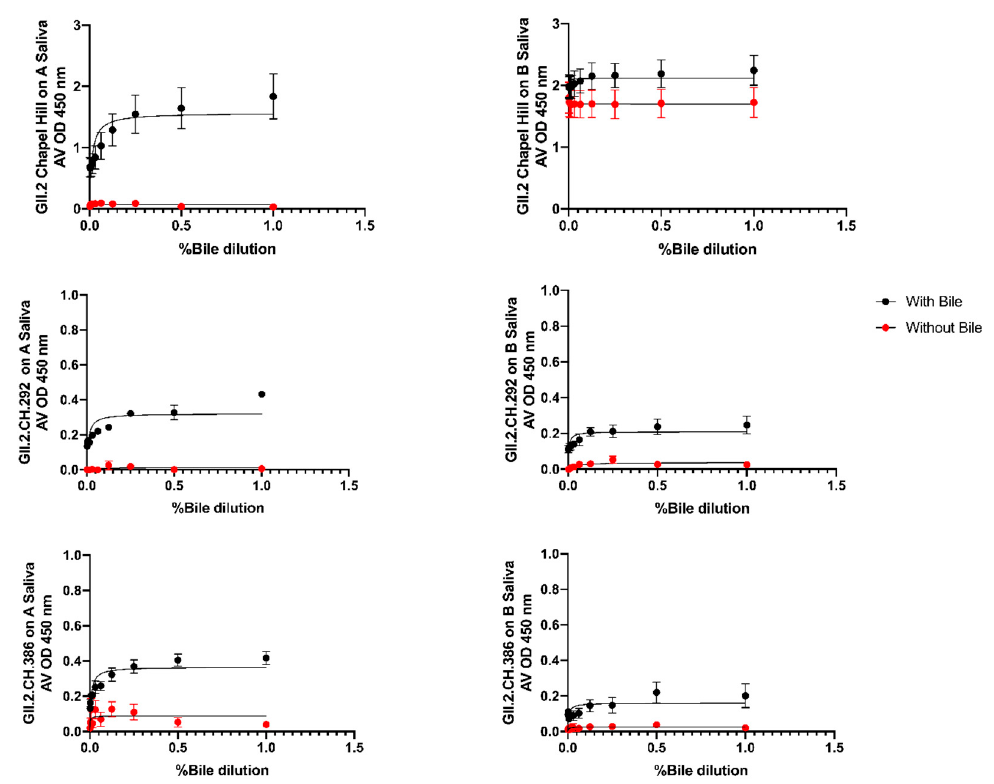
Figure 7. Bile Restores A and B saliva binding in two of the GII.2.CH Alanine mutants: GII.2.CH alanine mutants were screened for binding to A and B saliva in the presence of bile. One-site specific binding curves were fit with error bars representing standard error of the mean.